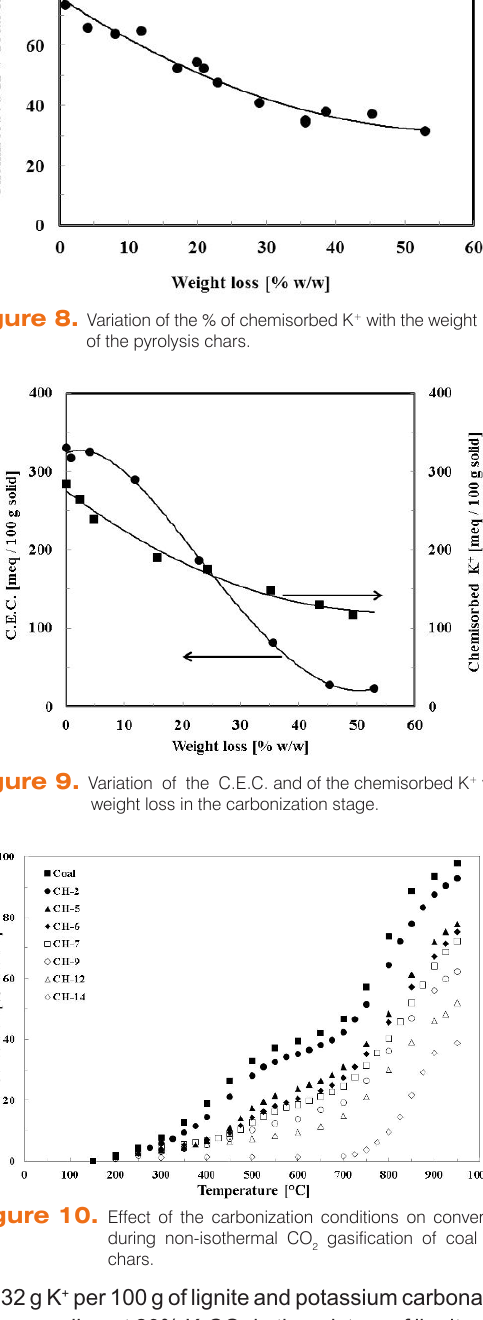
(cid:3) (cid:74)(cid:68)(cid:86)(cid:76)(cid:287)(cid:70)(cid:68)(cid:87)(cid:76)(cid:82)(cid:81)(cid:3) (cid:82)(cid:73)(cid:3) (cid:70)(cid:82)(cid:68)(cid:79)(cid:3) (cid:68)(cid:81)(cid:71)(cid:3) 2